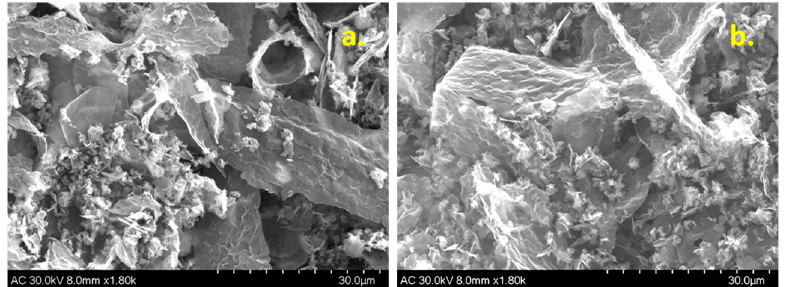
Figure 5. Representative SEM micrographs of: EGR-1 sample ( a ) and EGR-2 sample ( b ).